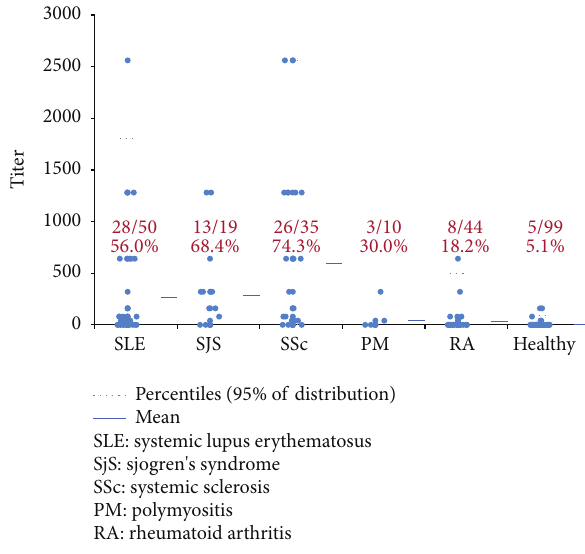
Figure 3: Comparative receiver operating characteristic (ROC) analyses. ROC for manual indirect immunofluorescence (IIF) manual interpretation and NOVA View results for ANA related autoimmunerheumaticdisease(AARD)versushealthycontrolsand rheumatoid arthritis (RA). The ROC curves were similar for manual IIF and NOVA View, and as expected, specificity improves for both methods when RA patients are removed from analysis.